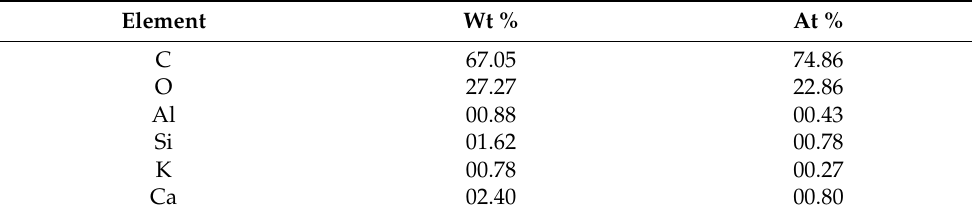
Figure 5. Typical EDS spectrum registered for the textolite material with slightly marked degradation effects. There was already a low content of fibreglass support elements, namely, silicon (Si), calcium (Ca) and aluminium (Al), at the levels of 1.1%, 2.4% and 0.4%, respectively. Table 1. Exemplary results of EDS tests on the surface of the textolite sample with slight degradation effects. Weight (Wt) and atomic (At) composition of the top layer of the laminate are presented as